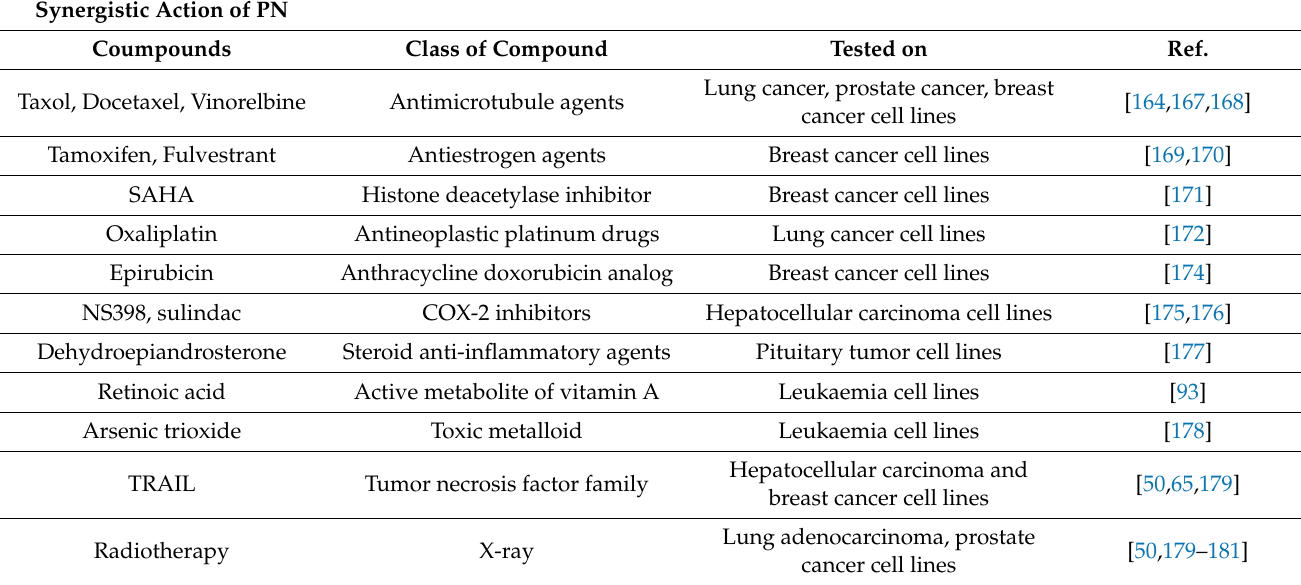
Table 1. Main classes of compounds that have a synergistic action in association with